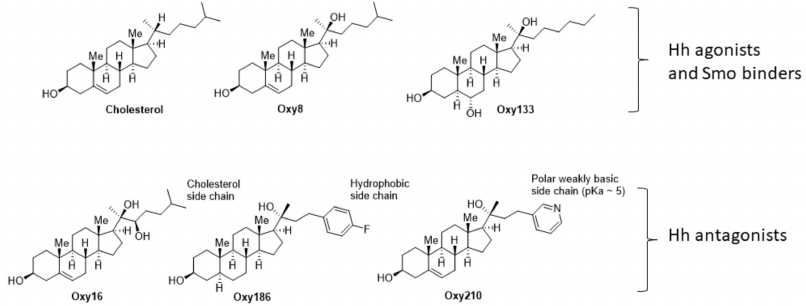
Figure 1. The molecular structures of Cholesterol, Oxy8, Oxy133, Oxy16, Oxy186 and